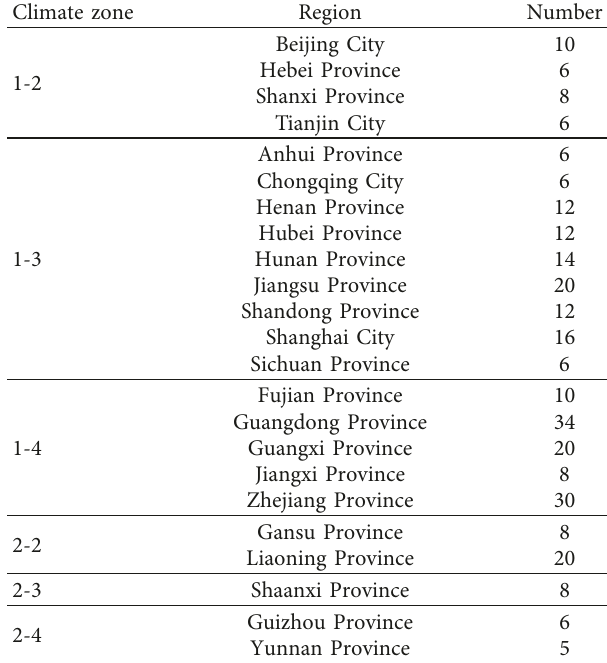
Table 1: Details of surveyed asphalt pavements. Climate zone